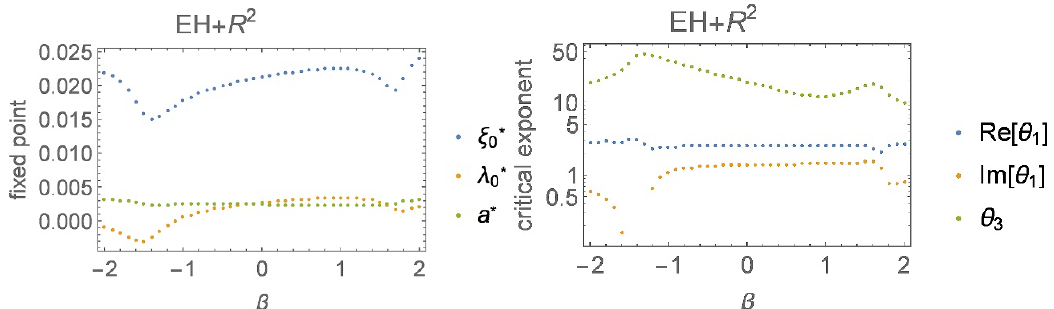
Figure 5 . The dependences of the stable (cid:12)xed point and the stable critical exponent on (cid:12) in the \EH" truncation.